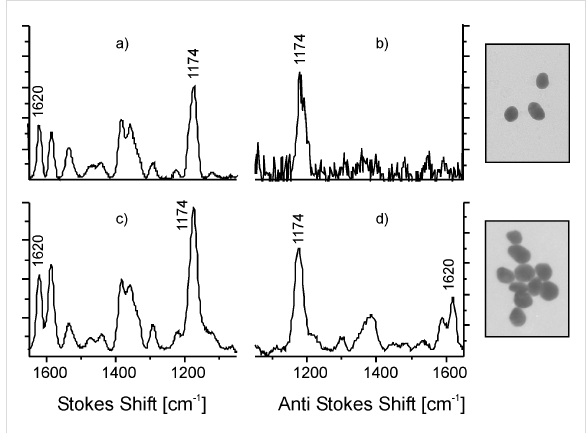
Figure 2: Stokes and anti-Stokes SERS spectra of crystal violet under conditions of “normal” SERS (a,b) and extremely strong SERS (c,d) [31]. Spectra were measured by using 830 nm non-resonant excitation. Reprinted with permission from [22], Copyright 2006 American Chem- ical